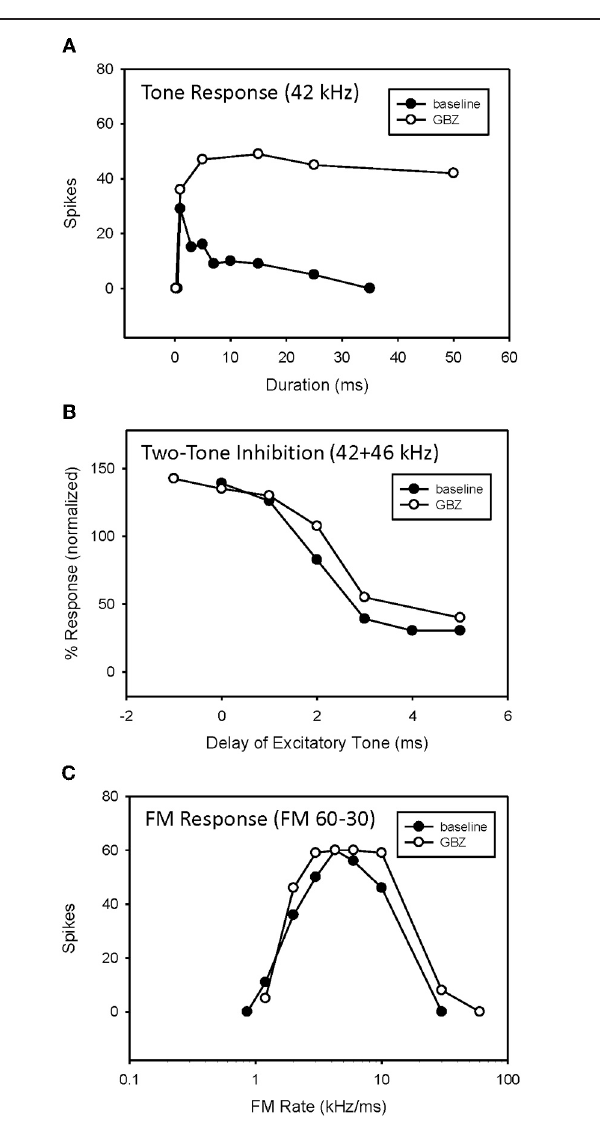
FIGURE 7 | Application of GBZ converted duration tuning from bandpass to longpass (A) but did not eliminate HFI (B) or bandpass FM rate selectivity (C) in this